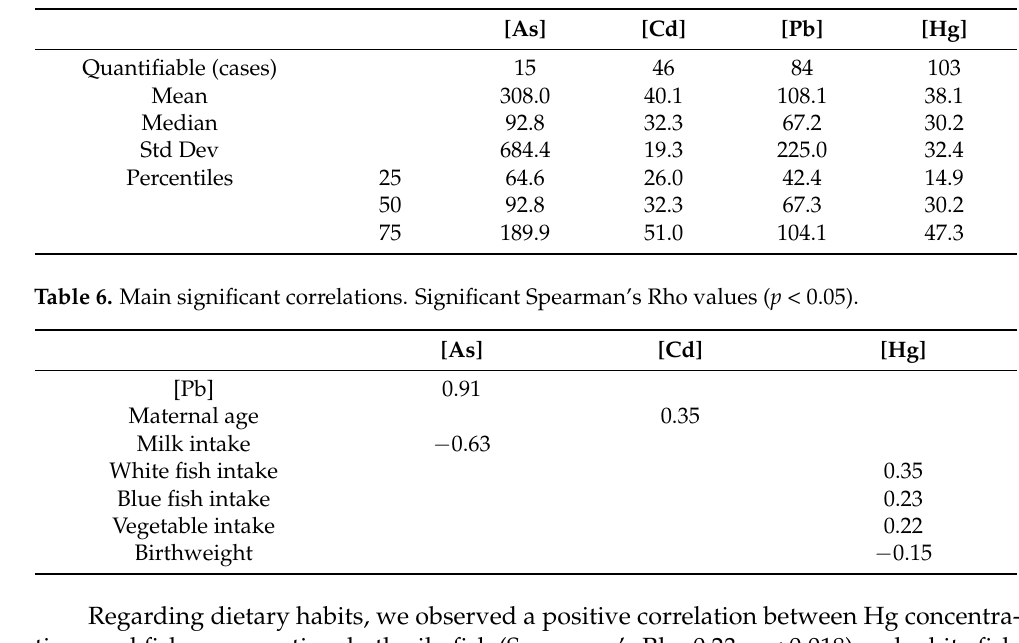
Table 5. Concentration of heavy metals measured in microg/Kg in placental samples. [As] [Cd] [Pb] [Hg] Quantifiable (cases)